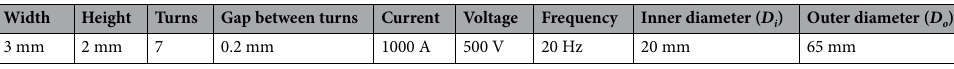
Table 1. Designed coil parameters.